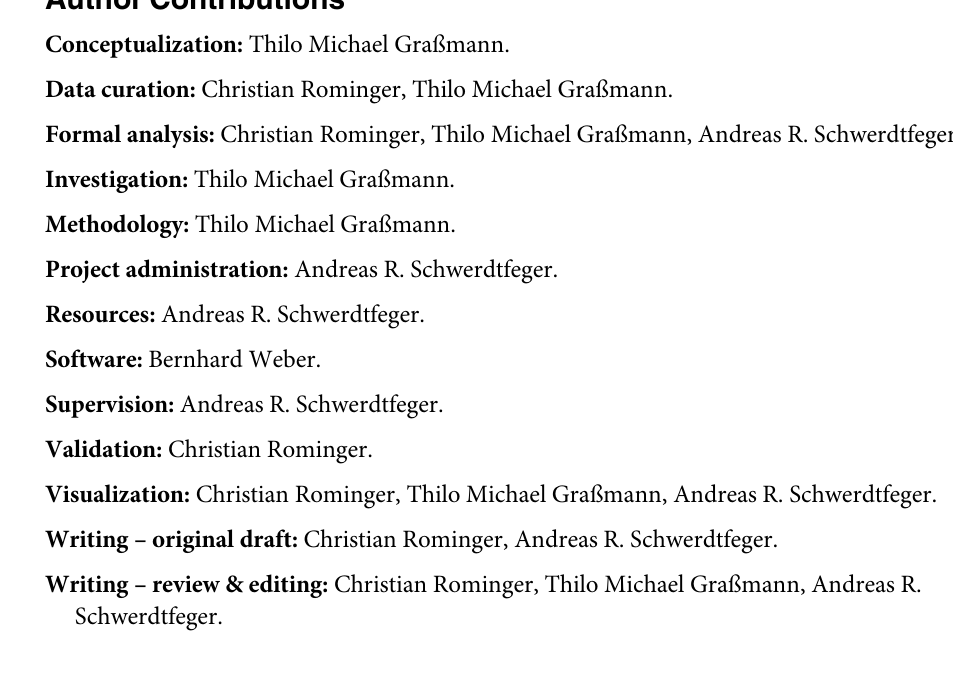
S1 Fig. Hypotheses chart. Distribution of likelihood ratios for observed data under an alterna- tive hypothesis vs. under the null hypothesis. The graph is based on an adapted R script pro- vided by Uri Simonsohn (see http://datacolada.org/appendix/78/hypchart%20post%202019% 2009%2011.R). The inverse value of the presented likelihood ratio represents the ratio that data are more likely under the null hypothesis vs. under an alternative hypothesis (e.g., d =